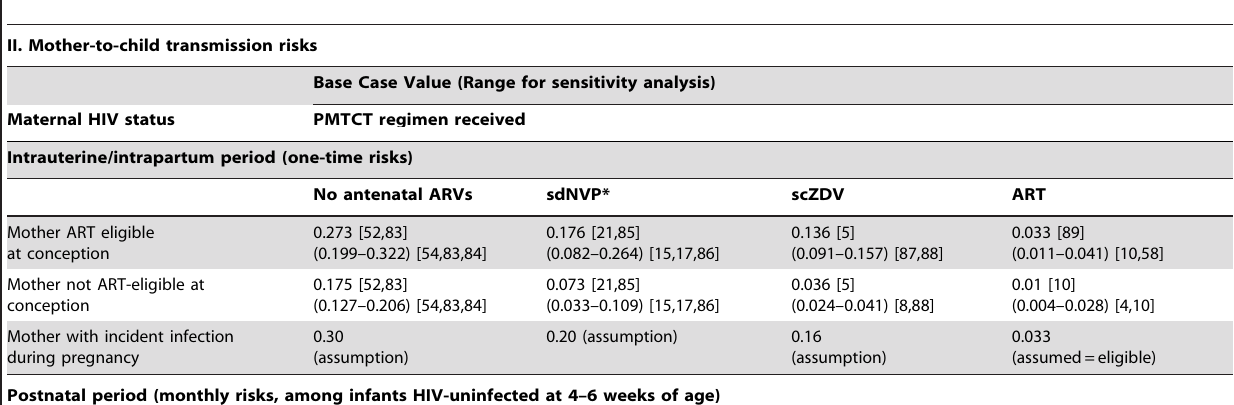
Table 2. Selected model input parameters for a simulation model of strategies to prevent mother-to-child transmission of HIV in Zimbabwe: Pediatric